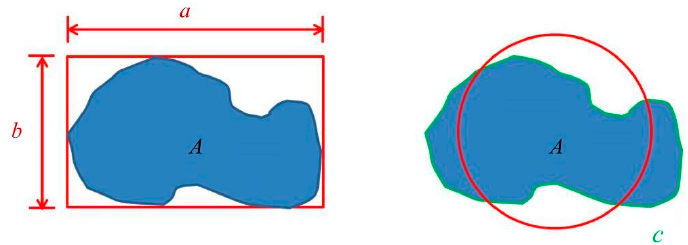
Figure 3. Parameters of spheroidization degree definition. a , b , c , and A represent the major axis, minor axis, perimeter, and area of a grain, respectively. axis, perimeter, and area of a grain,